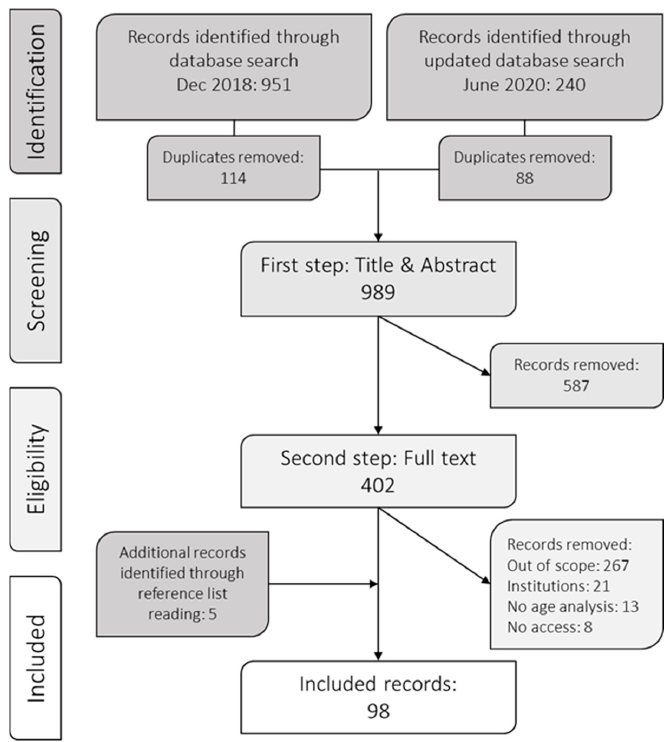
Figure 1. Flowchart of screening process.